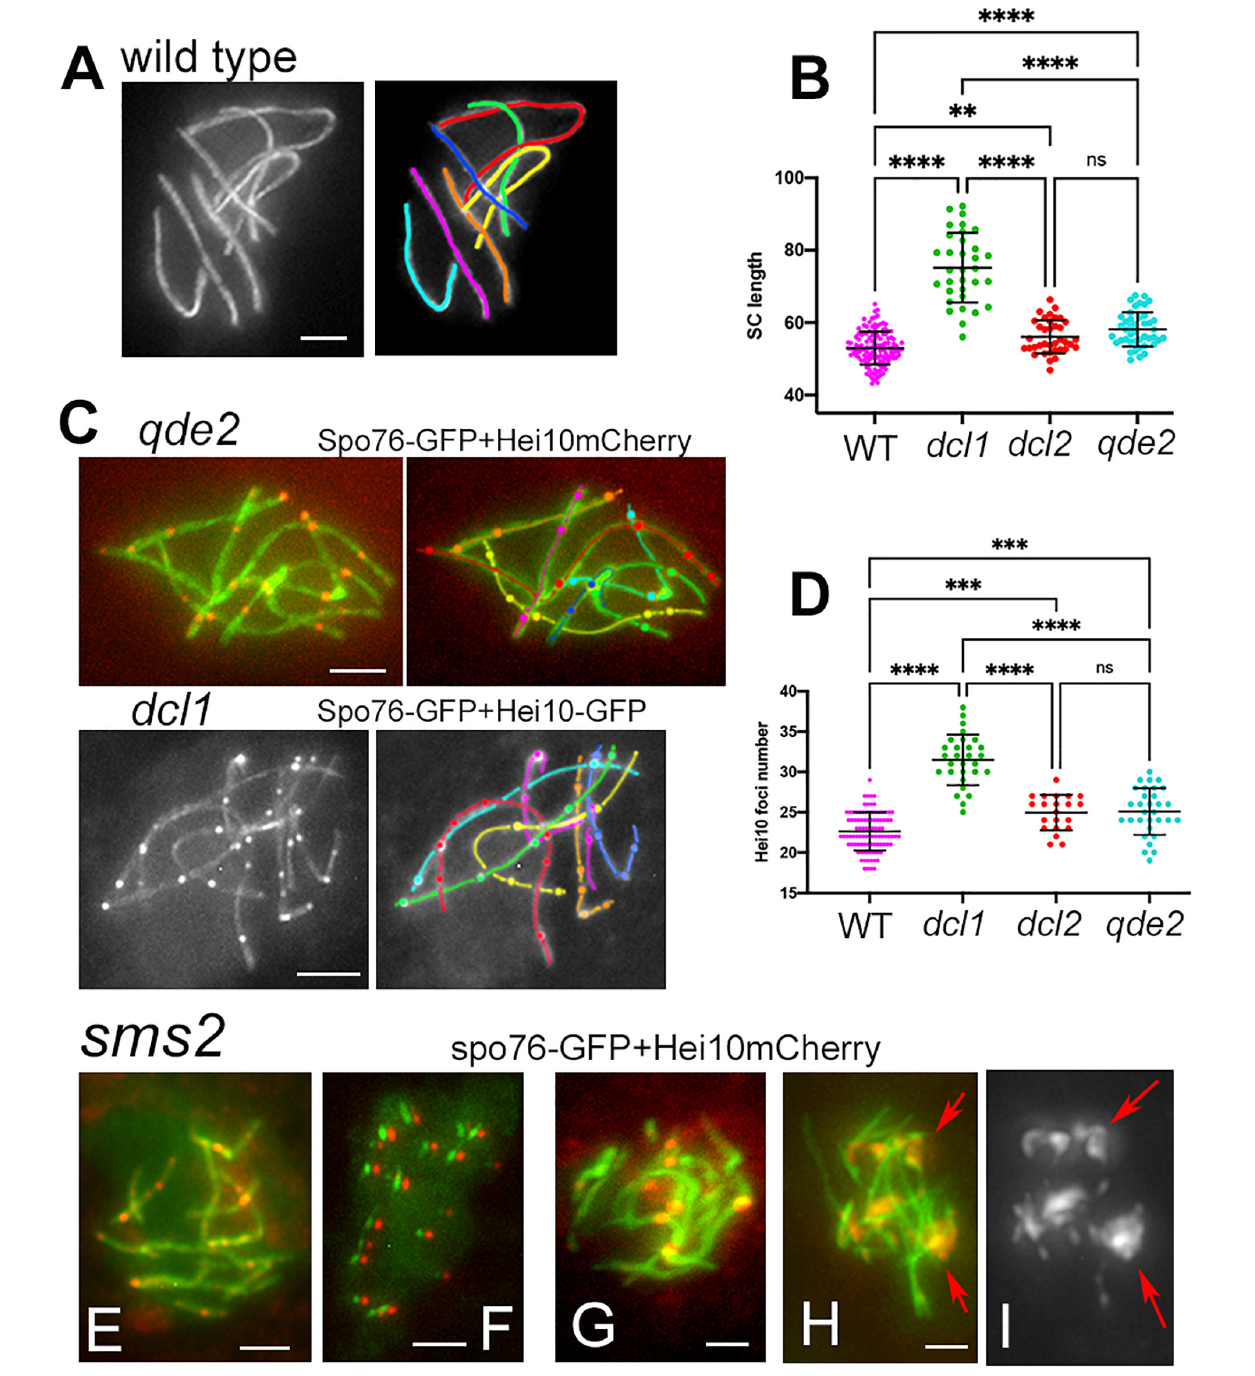
FIGURE 4 | Axis lengths and crossover numbers in WT, dcl1, dcl2, and qde2 mutants plus Hei10 foci in sms2 . (A) Wild-type pachytene nucleus with 7 Spo76-GFP marked SCs. (B) SC lengths per nucleus in WT and mutants; means with standard deviations; P -values: ∗∗ p < 0.01; ∗∗∗∗ p < 0.001. (C) Examples of Hei10 foci localization along the seven homologs of qde2 (top) and dcl1 (bottom). Axes are marked by Spo76-GFP and foci are marked either by Hei10-mCherry ( qde2 ) or by Hei10-GFP ( dcl1 ). (D) Number of Hei10 foci per nucleus in WT and mutants; double lines indicate standard deviations; P -values: ∗∗ p < 0.01; ∗∗∗∗ p < 0.001. (E–I) sms2 mutant. (E) Nucleus with extra SCs (see Figure 3C ) but wild-type like Hei10 foci [compare with the qde2 nucleus in (C) ]. (F) At early diffuse stage, only small SC segments (green) are left but they contain all one Hei10 focus (red). Green and red signals from SC and foci, respectively, were shifted for easier observation. (G) SCs are abnormal in length and shape and foci are larger than normal [compare with (E) ]. (H,I) Nucleus with large Hei10 foci with (H) and without (I) Spo76-GFP. Foci are either single or aggregated [red arrows in (I) ]. Bars, 2 µ m.